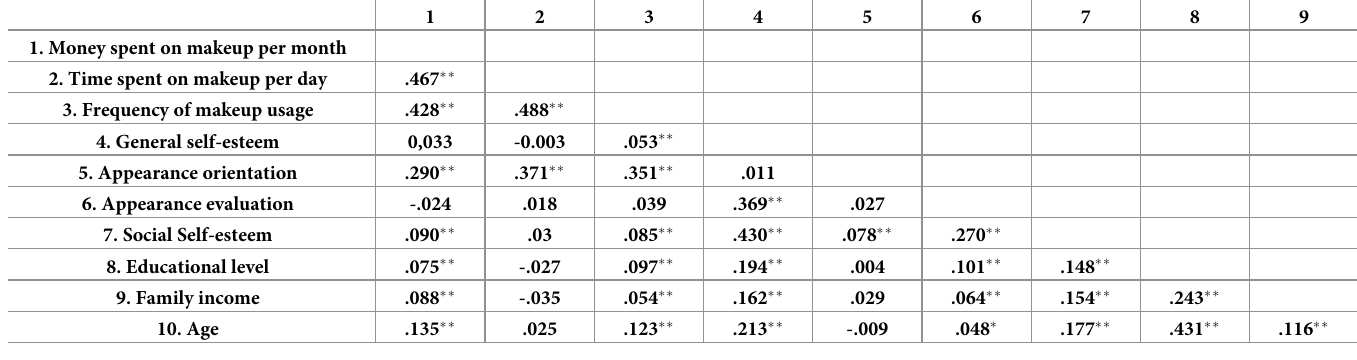
Table 1. Kendall correlations between makeup usage, social self-esteem, general self-esteem, body image, and sociodemographic